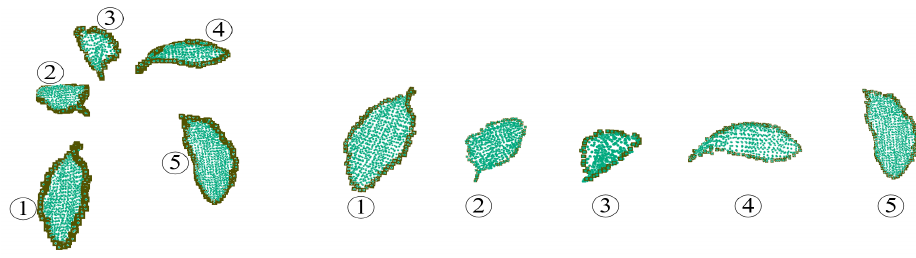
Figure 9. Extraction edge points of leaves by boundary conditions method.